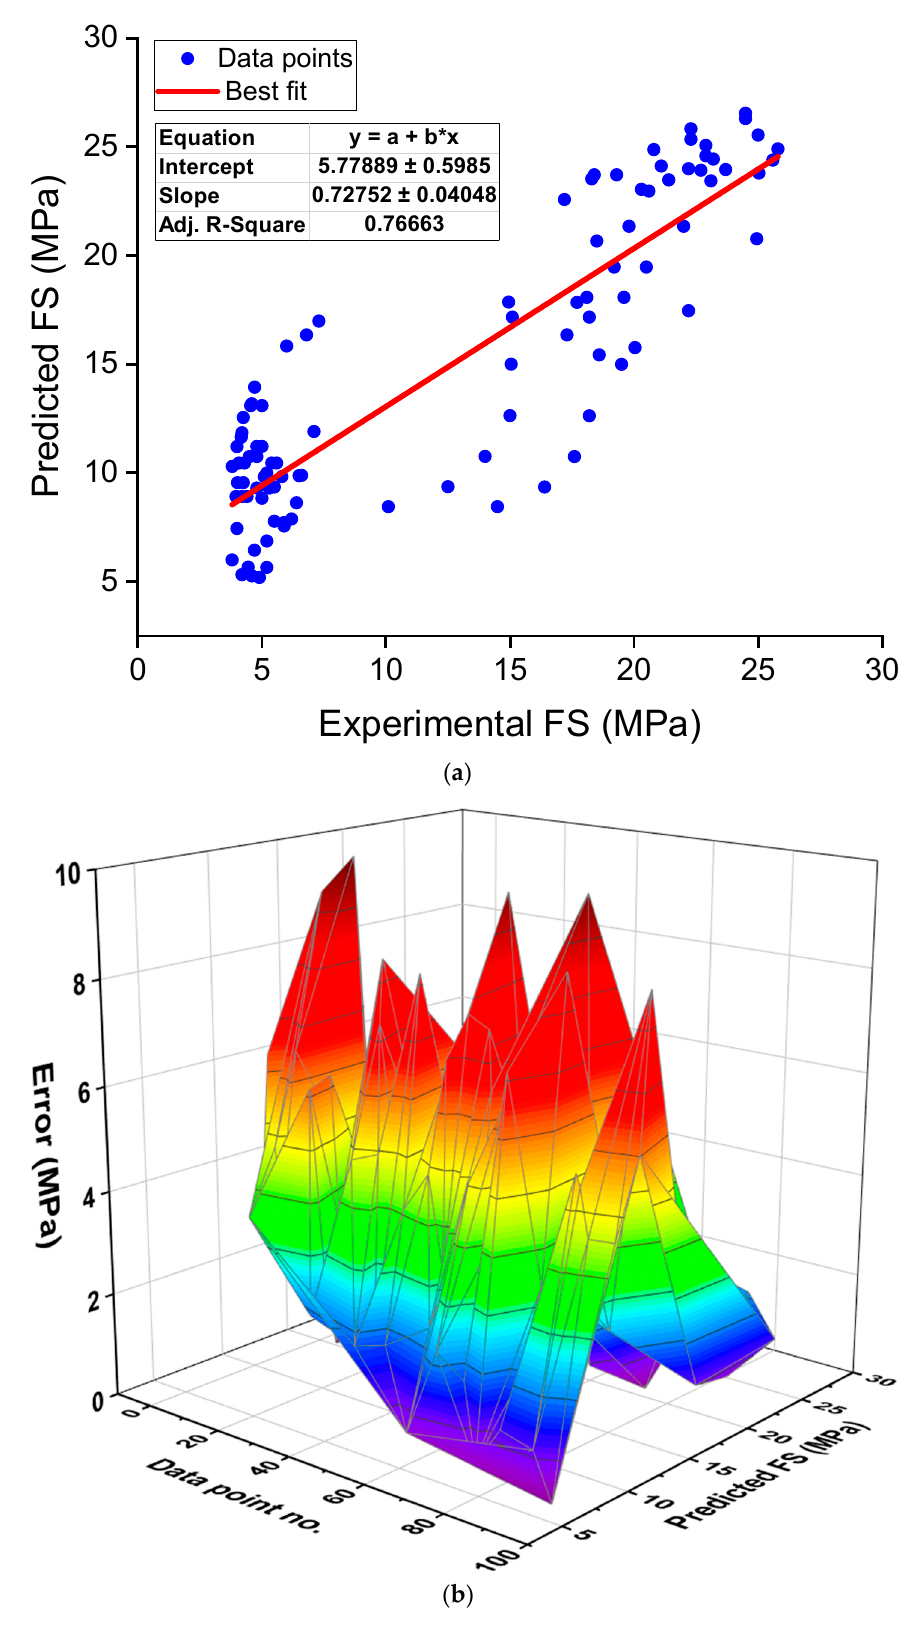
Figure 11. Regression model for FS: ( a ) correlation between actual and predicted results; ( b ) distribution of predicted and error values.